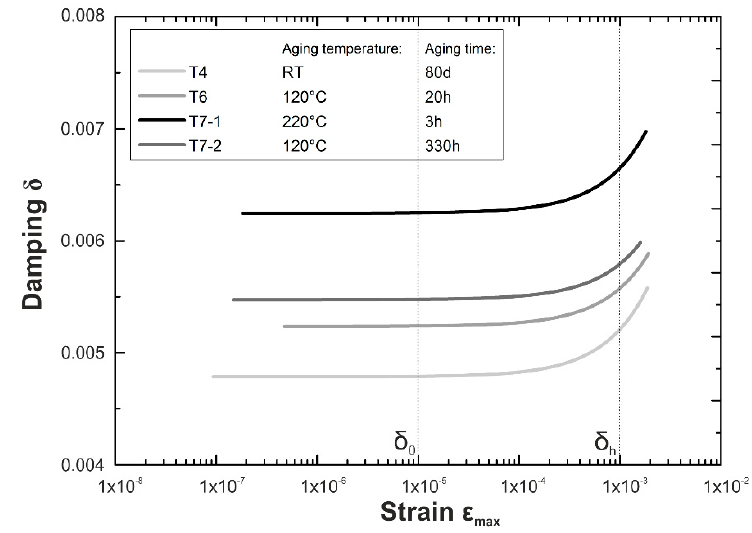
Figure 2. Strain-dependent damping measurements of the aluminum alloy AA7075.